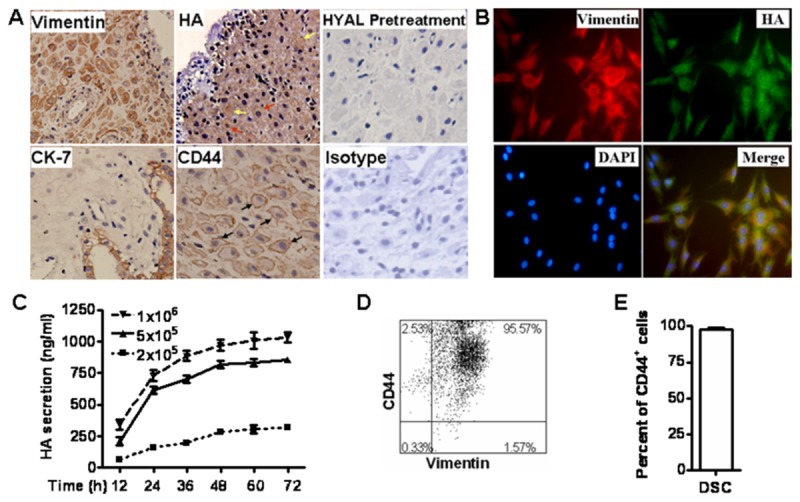
Expression of HA and its receptor CD44 in DSCs from human early pregnancy.HA and CD44 expression was confirmed by immunohistochemistry, immunofluorescence, ELISA and flow cytometry, respectively. (A) The decidual tissues from normal early pregnancy were stained for HA and CD44. Slides were pretreated with HYAL to determine the specificity of HA. The red and yellow arrows showed HA staining in the cytoplasm and extracellular matrix, respectively (C) Primary DSC cells were seeded at 2×105, 5×105, or 1×106 cells/ml in cell culture plates. After 12, 24, 36, 48, 60 and 72 h of culture, the supernatants were collected and measured by ELISA. Each point represents the mean ± SE of triplicate values from four independent experiments. (D, E) The primary DSCs were stained by CD44 and vimentin, and the percentage of CD44+Vimentin+ DSC cells was analyzed by flow cytometry (FCM). The flow cytometric picture is from three different experiments.